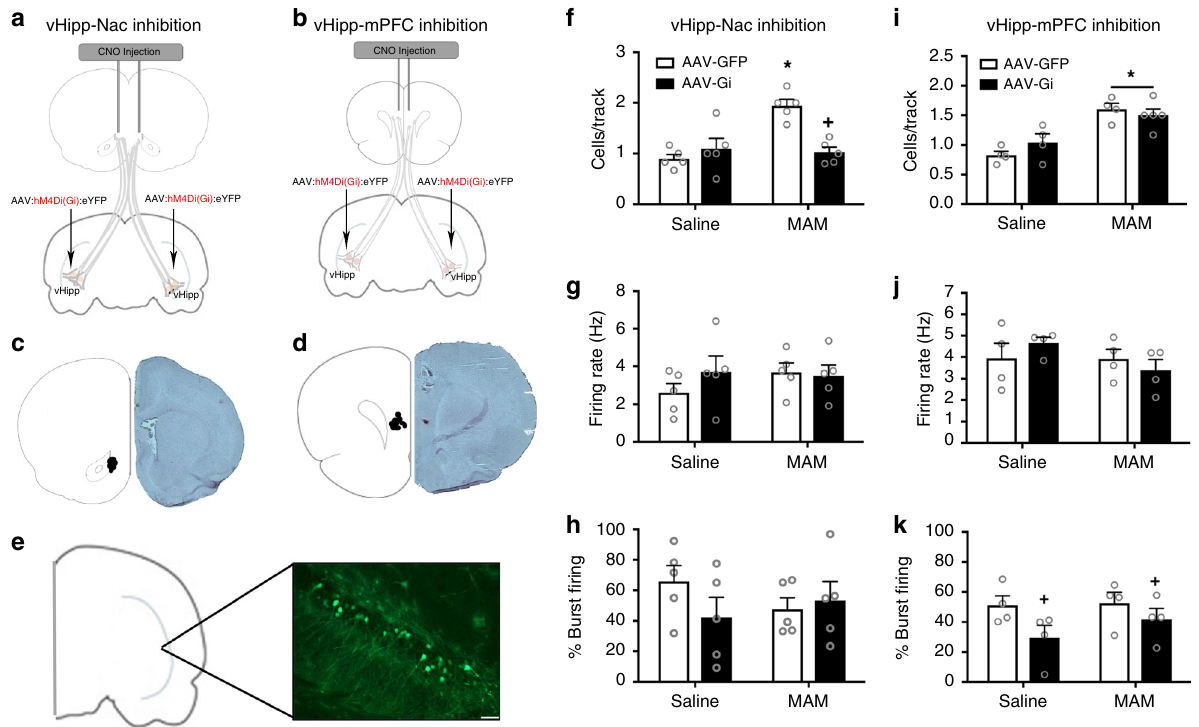
Fig. 4 Inactivation of the vHipp-NAc normalizes dopamine population activity in MAM-treated rats. The schematic depicting the strategy used for pathway inhibition is shown in a, b . An adeno-associated virus that expressed the Gi DREADD was injected into the vHipp. At the time of testing, CNO was injected directly into the NAc ( a ) or mPFC ( b ). Cartoon showing the location of the CNO injection and micrograph of representative section are shown in c, d . DREADD expression in pyramidal cells of the vHipp was con fi rmed using immunohistochemistry and a representative image is shown in e 70 . n = 3 rats per group. Scale bar is 50 microns. MAM-treated animals show an increase in the number of spontaneously active dopamine cells per track in the VTA compared to saline controls. Chemogenetic inactivation of vHipp afferents to the NAc completely abolishes the MAM-induced increase in dopamine population activity ( f ). Neither fi ring rate ( g ) nor the percentage of action potentials fi red in bursts ( h ) were affected by MAM treatment or pathway inhibition. n = 5 rats per group. Asterisk is signi fi cantly different from saline/GFP; + plus is signi fi cantly different than MAM/GFP. The MAM-induced increase in dopamine cell population activity is not affected by inhibition of the vHipp to mPFC pathway ( i ). Neither MAM treatment nor pathway inhibition affect fi ring rate ( j ). The percentage of action potentials fi red in a burst pattern was decreased by vHipp-mPFC pathway inhibition in both the saline- and MAM-treated animals ( k ). n = 4 – 5 rats per group. Asterisk is signi fi cantly different from saline; + plus is signi fi cantly different than GFP. All data were analyzed using Two-Way ANOVA and Holm – Sidak tests. Data are shown as mean ±